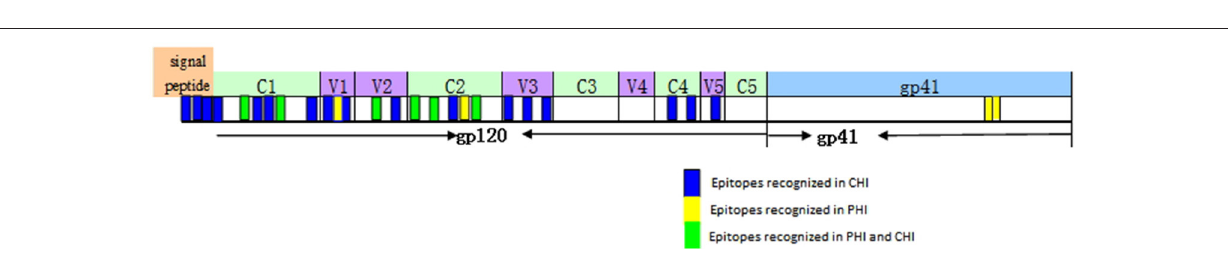
FIGURE 5 | The location of epitopes recognized by ADCC responses in individuals with PHI and CHI. Thirty-three single peptides were identified by analysis of the ADCC responses of individuals with PHI and CHI. Ten single peptides (blue and green), primarily located in the V1/C2 domain were identified in PHI group. Twenty-three single peptides (yellow and green), mainly located in the C1/V1/C2/V3 region, were identified in CHI group.